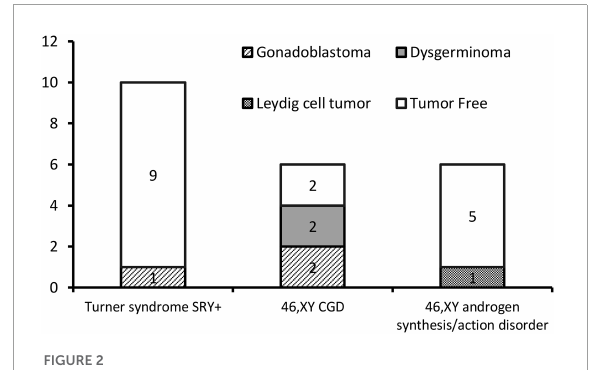
FIGURE2 Number of gonadal tumors according to different